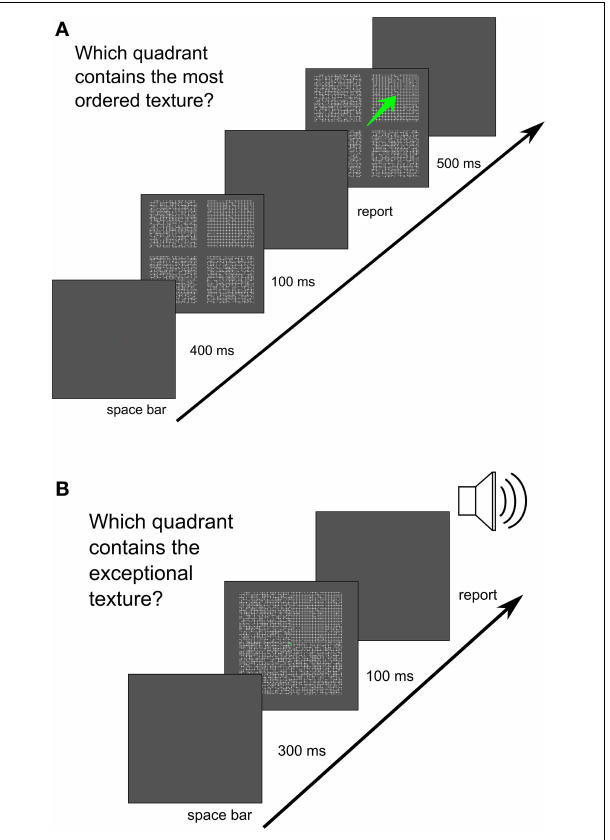
FIGURE 7 | Display sequence used in the experiment. (A) Sequence used in Experiment 1. (B) Sequence used in Experiments 2 and